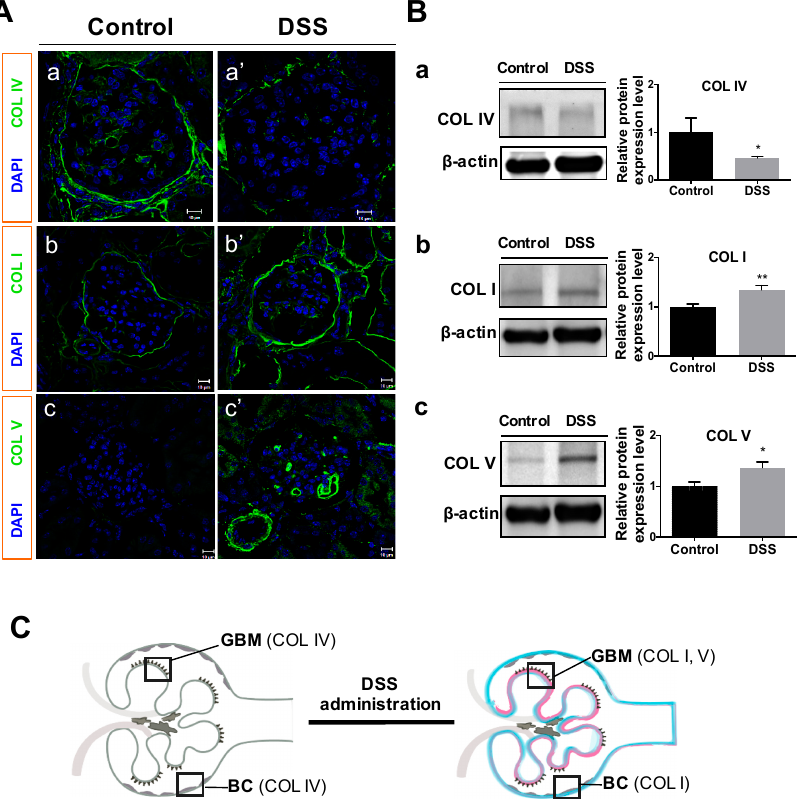
Figure 4. Changes in glomerular collagens in mice after DSS administration. Immunofluorescent microscopy ( A ) and Western blot analysis of protein expression ( B ) for type IV collagen (COL IV; A-a, A-a’; B-a; 160–190 kDa), type I collagen (COL I; A-b, A-b’; B-b; 150 kDa), and type V collagen (COL V; A-c, A-c’; B-c; 220 kDa) were conducted for control and DSS-colitis mice. Representative bands ( B , left) and relative band intensity ratios were analyzed ( B , right). ( C ) Illustration of glomerular collagens changes in this study. All values are means ± SEM ( n = 6); * p < 0.05 and ** p < 0.01 vs. control. Scale bars = 10 µ m. Abbreviations: GBM, glomerular basement membrane; BC, Bowman’s capsule.